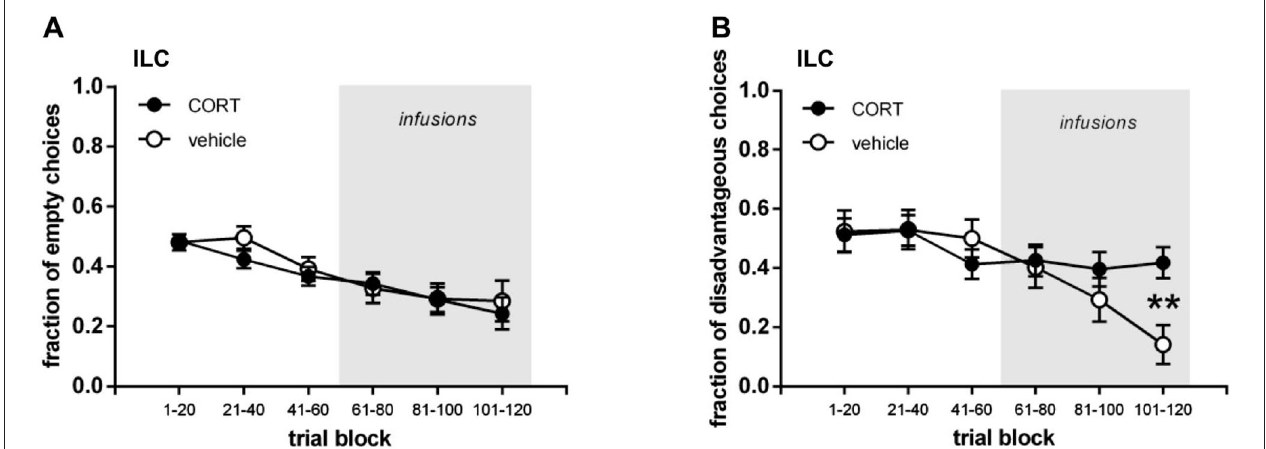
FIGURE 2 | Infralimbic cortex (IL) cannulated groups. (A) Mean ( ± SEM) fraction of visits to empty arms. (B) Mean ( ± SEM) fraction of visits to disadvantageous arm. ** p < 0.001.